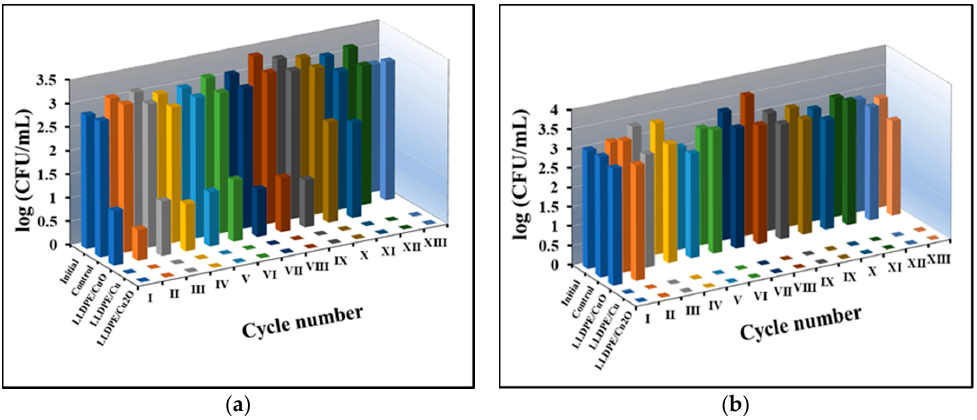
Figure 7. Activity of the NPs-LLDPE composites obtained by thermal adhesion against ( a ) S. aureus and ( b ) E. coli cells. Roman figures show the number of re-use cycles. Initial— S. aureus ( a ) and E. coli ( b ) cells before incubation, Control— S. aureus ( a ) and E. coli ( b ) cells after 30 min incubation; LLDPE/Cu 2 O— S. aureus ( a ) and E. coli ( b ) cells after 30 min incubation with the Cu 2 ONPs-LLDPE composite; LLDPE/Cu— S. aureus ( a ) and E. coli ( b ) cells after 30 min incubation with the CuNPs- LLDPE composite; LLDPE/CuO— S. aureus ( a ) and E. coli ( b ) cells after 30 min incubation with the CuONPs-LLDPE composite.